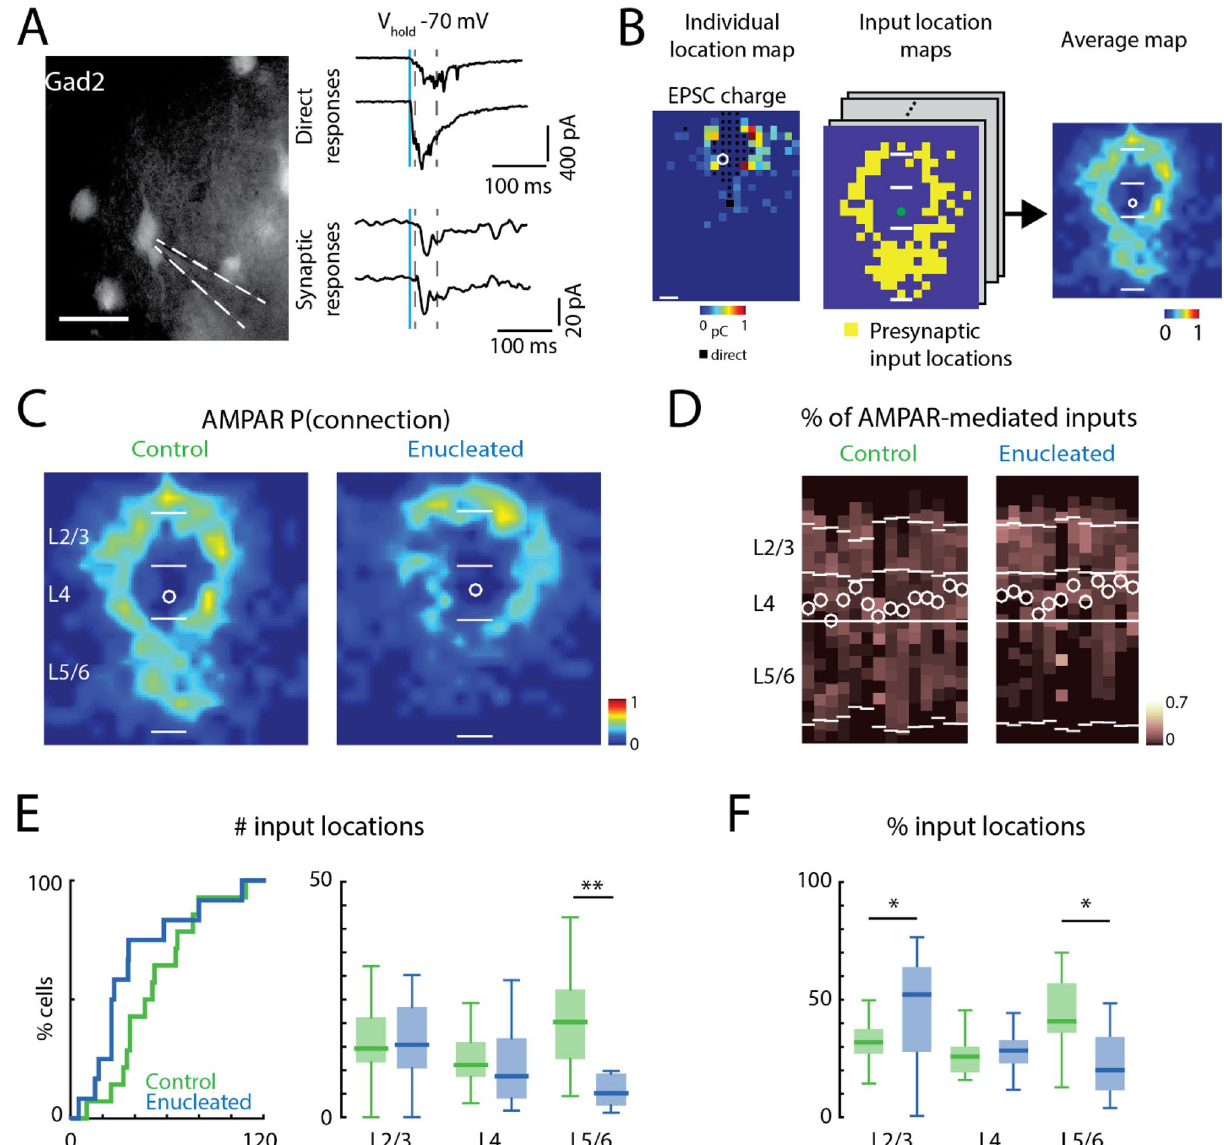
Figure 2. AMPAR-mediated cortical inputs to Gad2 interneurons from subgranular layers are reduced after enucleation. ( A ) An example Gad2-Cre::tdTomato interneuron under epifluorescence microscopy. Scale bar = 50 µm. Traces show example recordings of responses to direct photostimulation (upper traces) and responses to activation of presynaptic cells (lower traces). Blue line indicates photostimulation time point. Dashed lines indicate the time window (10 to 50 ms post-photostimulation) for identifying putative monosynaptic responses. ( B ) An exemplar input location map from LSPS experiments (left). The connected locations are color-coded based on the charge of the recorded EPSCs. Locations with black squares are affected by direct activation of the recorded neuron and are excluded in further analysis. White circle indicates the location of the recorded neuron. The locations of presynaptic cells are reconstructed into input maps (middle). Input maps are aligned to the soma and averaged to generate average input maps (right). ( C ) Average spatial connection probability maps of AMPAR-mediated inputs to L4 Gad2 interneurons in V1 at P16/P17 in control and enucleated animals (enucleated at P1/P2) (n = 14 control and n = 12 enucleated). Maps show the fraction of cells that received an input from a particular spatial location. AMPAR-mediated inputs from subgranular layers are decreased after enucleation. The length of the scale bars marking the layer boundaries is 100 μm. ( D ) Laminar distribution of inputs for each cell. Plotted is the fraction of input each cell received at each laminar location. Layer borders for each cell are indicated by horizontal white lines. Soma locations are indicated by white circles; cells are aligned to L4. ( E ) Quantification of the number of input locations. Cumulative distribution function (CDF) of the total number of input locations (left). P > 0.05. Boxplot (right) shows the number of input locations in each layer group. AMPAR-mediated inputs from L5/6 are decreased after enucleation. (**) indicates P < 0.01, otherwise P > 0.05. ( F ) Boxplot shows the average fraction of inputs from each layer. The fraction of L5/6 inputs is decreased after enucleation. (*) indicates P < 0.01, otherwise P > 0.05. For all panels: green, control group; blue, enucleation group. Statistics for ( E ) (left) are in the main text. Statistics for ( E ) (right) and ( F ) are in Table